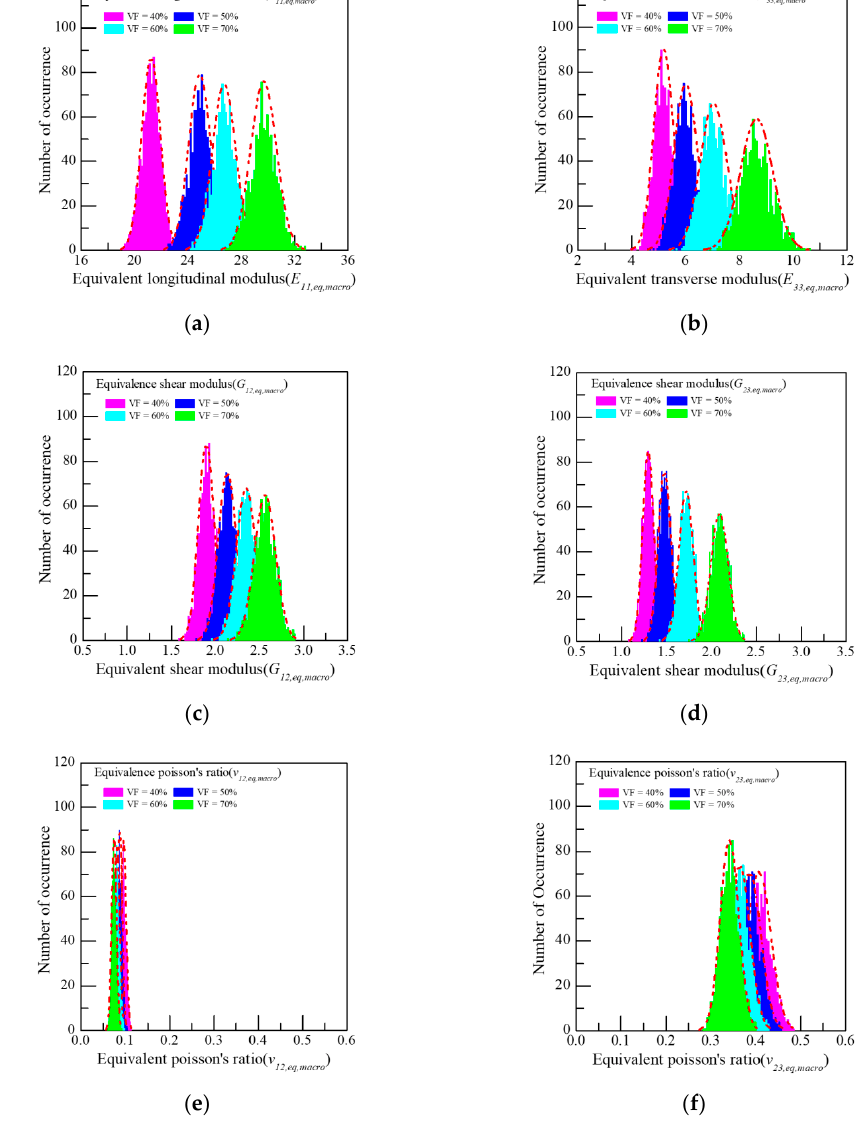
Figure 8. Result of MCS for the macro-level: ( a ) Equivalent longitudinal modulus ( E 11,eq,macro ); ( b ) Equivalent transverse modulus ( E 33,eq,macro ); ( c ) Equivalent shear modulus ( G 12 , eq,macro ); ( d ) Equivalent shear modulus ( G 23,eq,macro ); ( e ) Equivalent Poisson’s ratio ( v 12,eq,macro ); ( f ) Equivalent Poisson’s ratio ( v 23,eq,macro